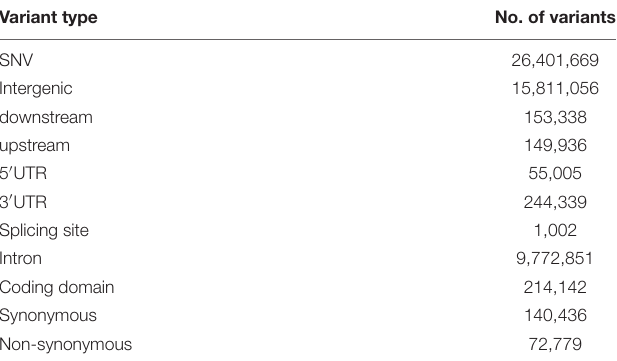
TABLE 2 | Annotation of the single nucleotide variants